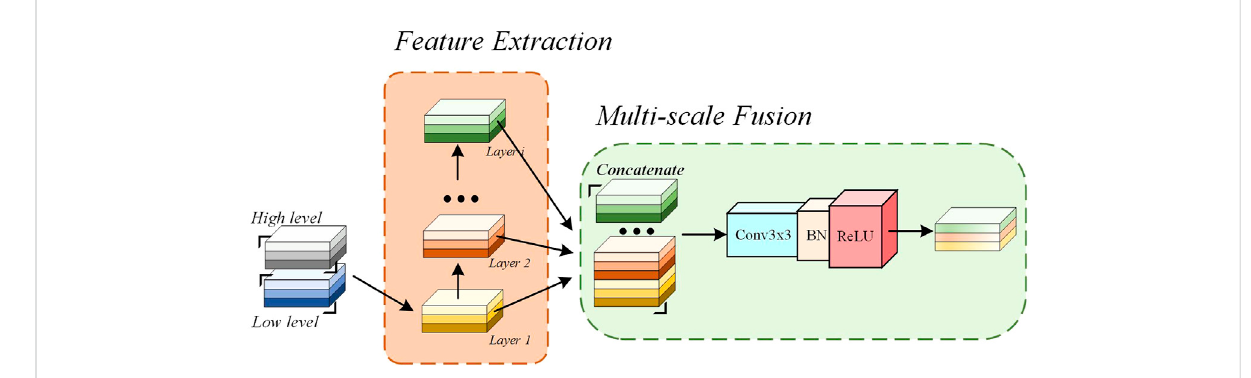
FIGURE 4 The Overview of the Proposed GHDC block.